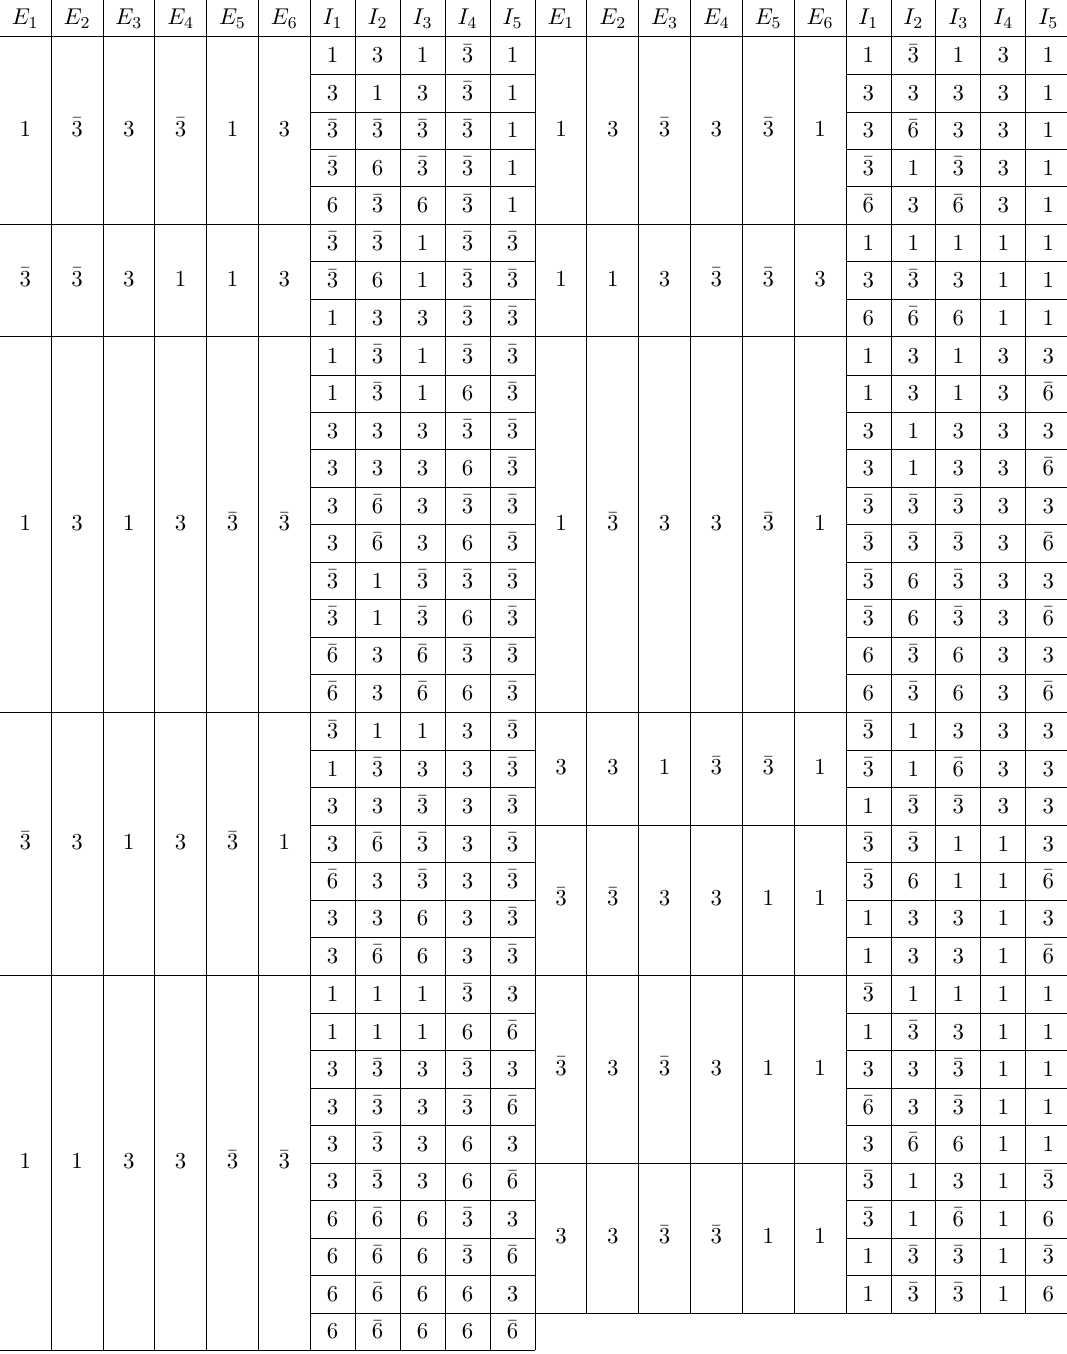
Table 3 . Assign the SU(3) C quantum numbers to fields of the topology N-1-1 in figure 1. The labels E i and I i of the external and internal fields are showed in figure